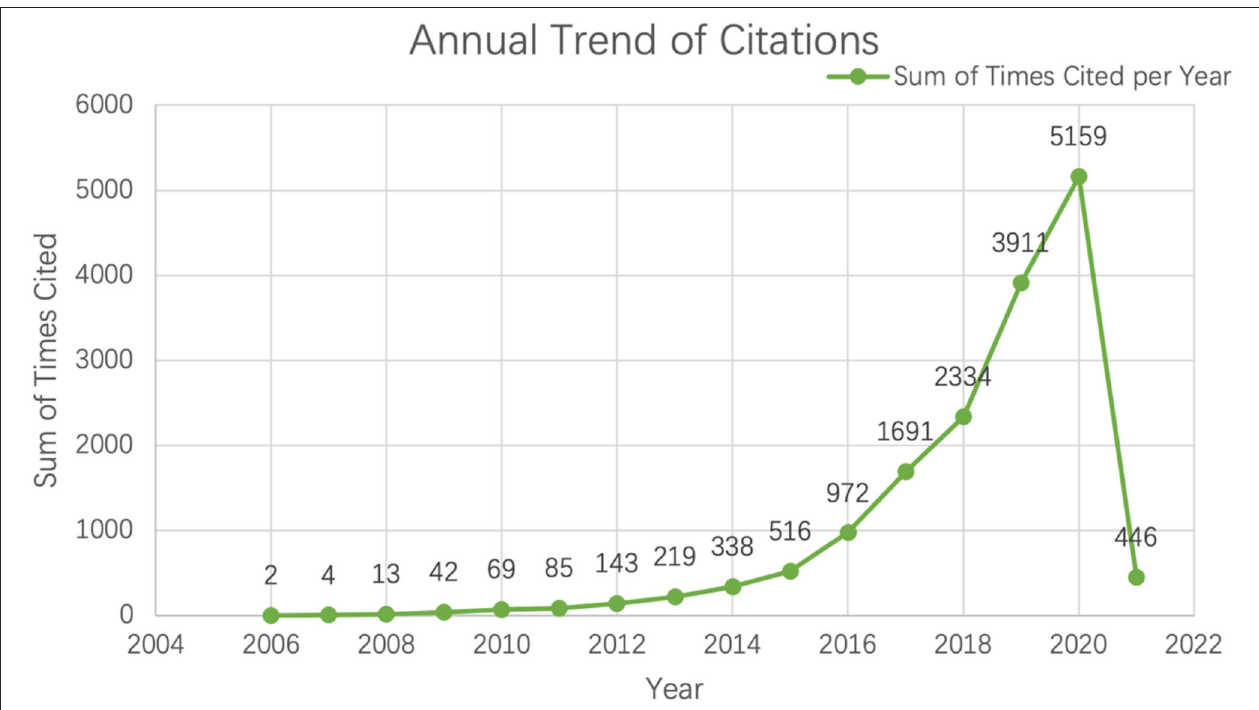
FIGURE 4 | Sum of times cited each year on web of